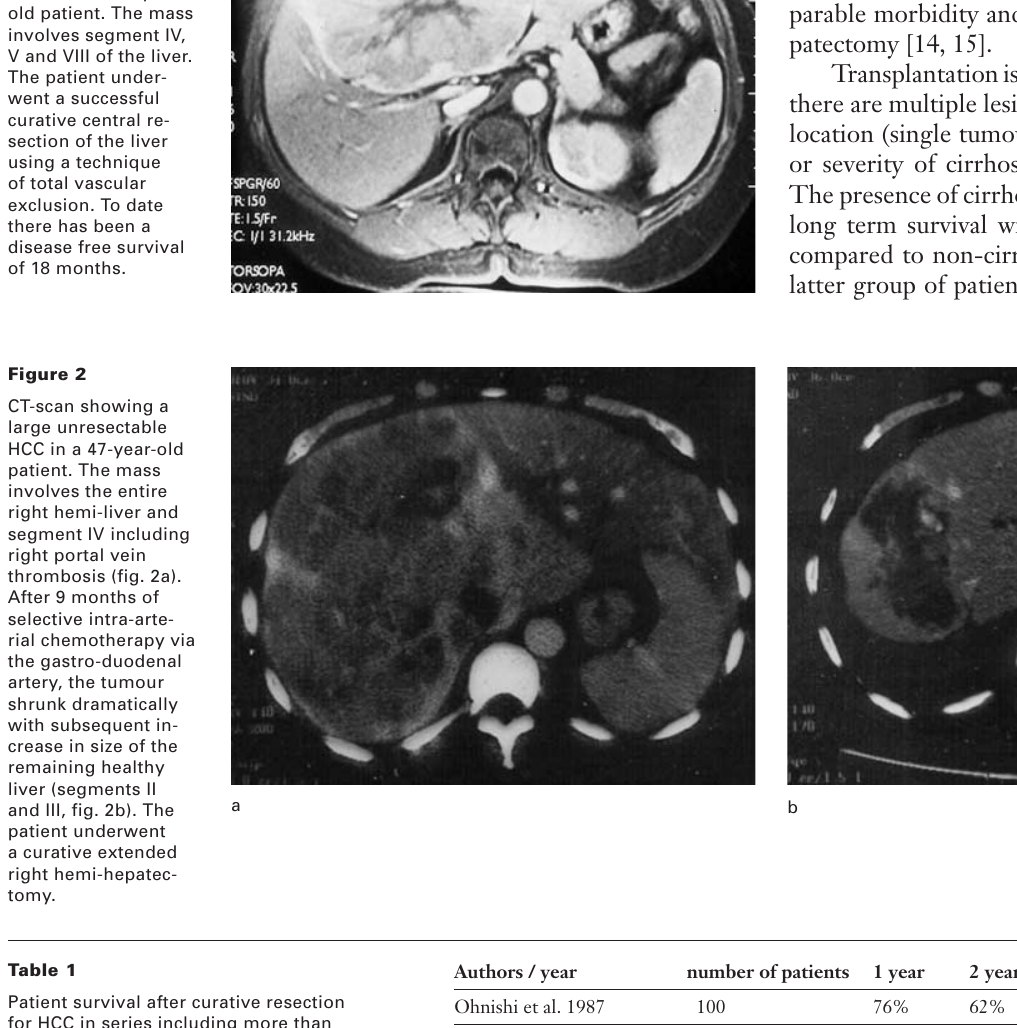
Patient survival after curative resection for HCC in series including more than 50 patients.